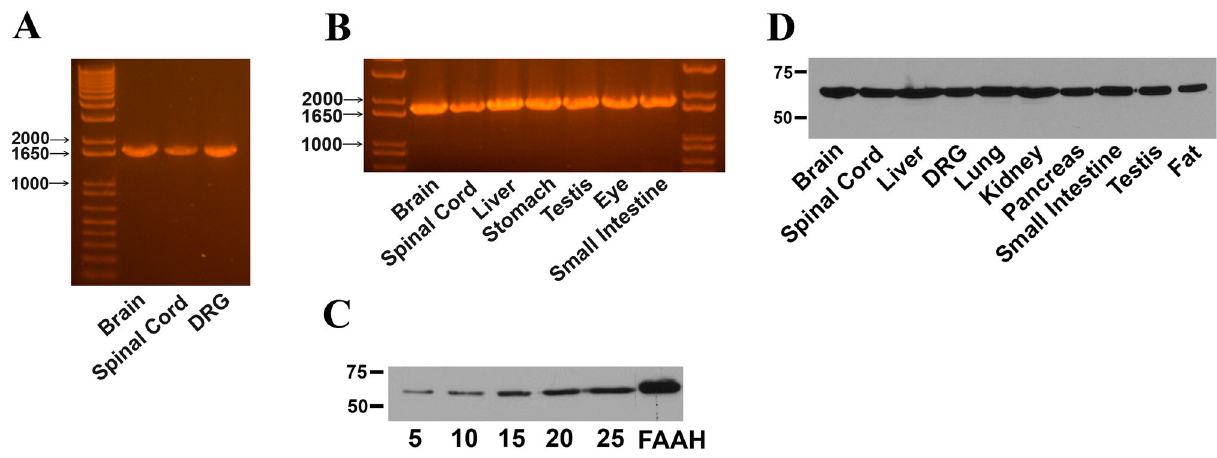
Figure 1. Expression of FAAH and FLAT in mouse tissues. (A) RT-PCR analysis of FAAH and FLAT expression in mouse brain, spinal cord, and L3-L5 DRG. Transcripts representing full-length FAAH (~1740 base pair fragments) were found in all tissues examined. In contrast, FLAT (~1540 base pair fragment) was not detected in any of the tissues. (B) RT-PCR analysis of FAAH and FLAT expression in mouse tissues. (C) Western blot demonstrating the expression of FAAH (~63 kDa) in mouse brain. Increasing the amount of brain tissue from 5 to 25 µg did not reveal the presence of FLAT, which has an expected molecular weight of ~56 kDa. FAAH-transfected HeLa cells are also shown. (D) Western blot of FAAH expression in a panel of mouse tissues.